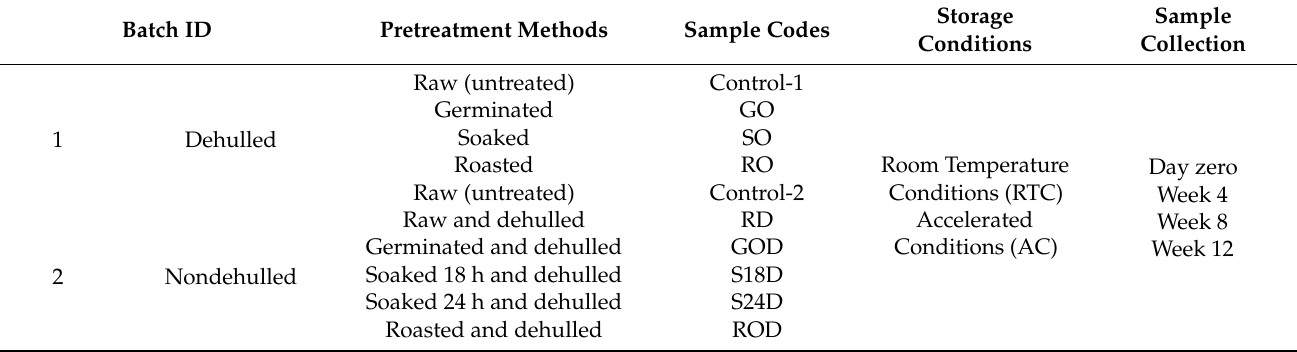
Table 1. Summary of experimental design of the oxidative stability under accelerated conditions study. Batch